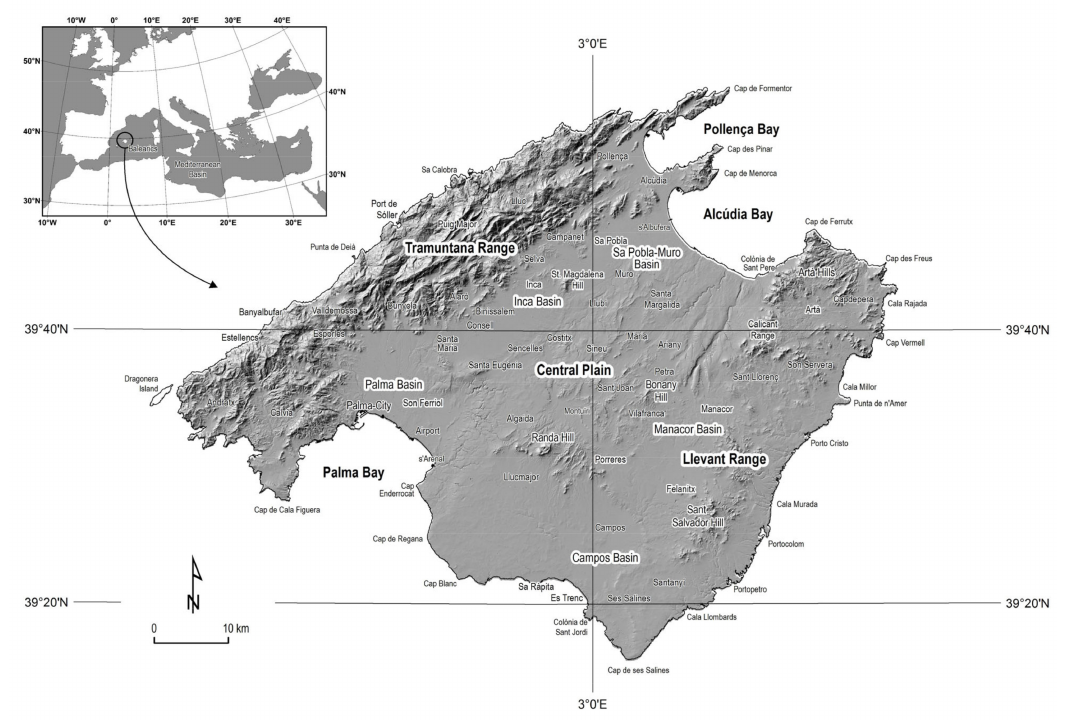
Figure 1. Geographical framework of the isle of